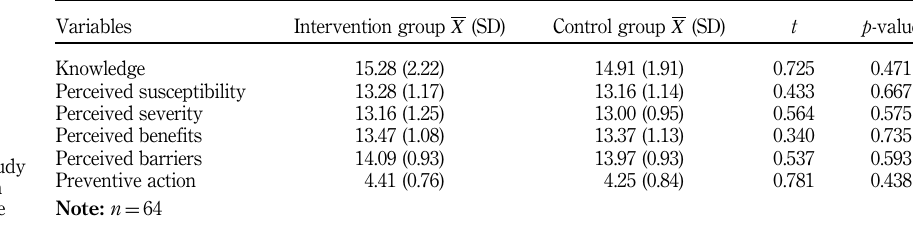
Table III. Comparison of study variables between groups at